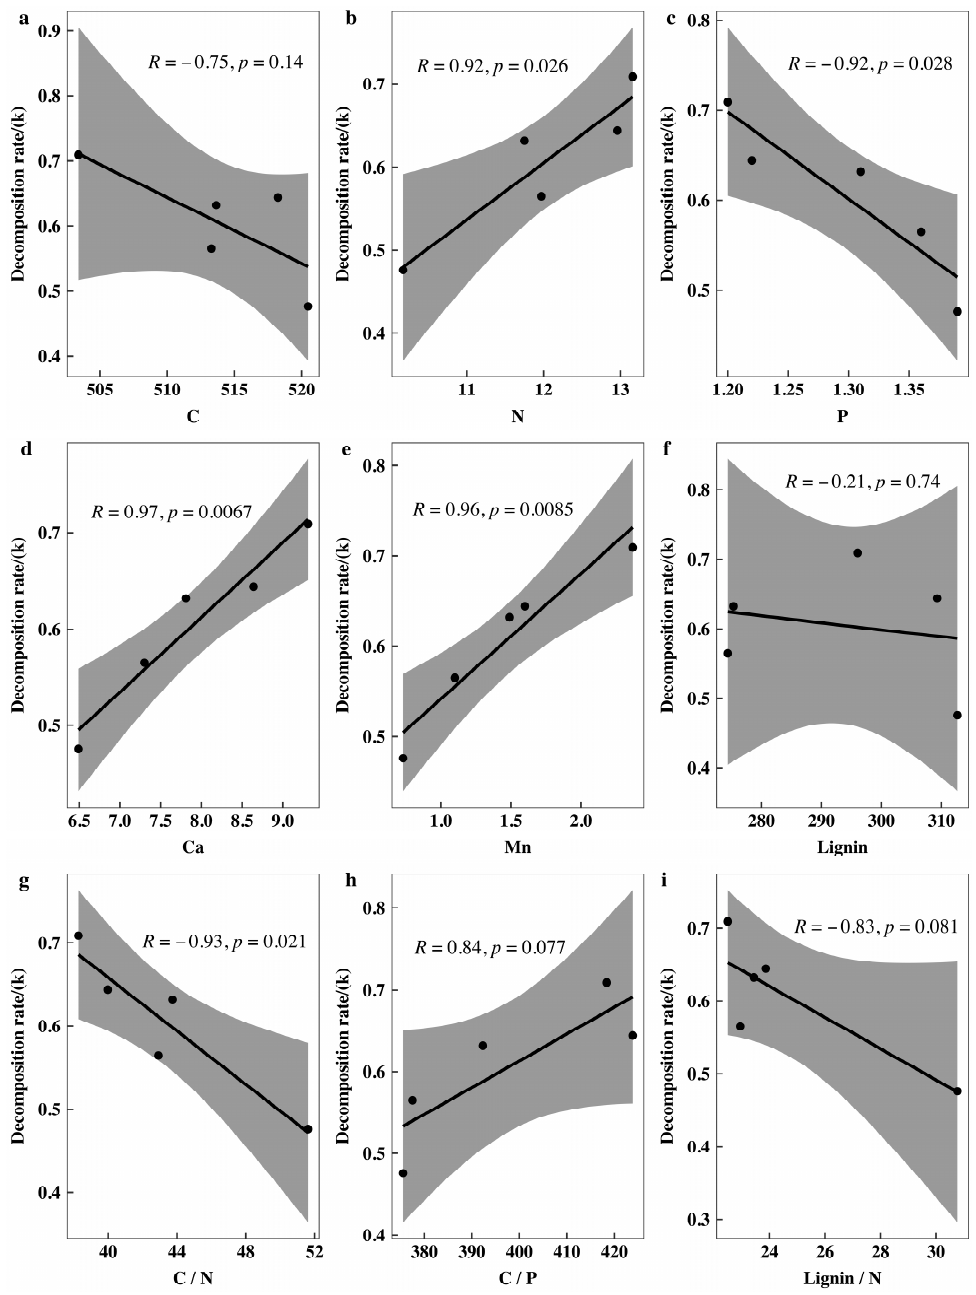
Figure 9. Relationships between the initial concentrations of some major nutrients, lignin, and eco- stoichiometric ratios in leaf litter (mg · g − 1 DM) taken from different altitude Qinghai spruce sites shown with the initial decomposition rate ( k ). ( a ) The relationship between C concentration and the initial decomposition rate of litter. ( b ) The relationship between N concentration and the initial decomposition rate of litter. ( c ) The relationship between P concentration and the initial decomposi- tion rate of litter. ( d ) The relationship between Ca concentration and the initial decomposition rate of litter. ( e ) The relationship between Mn concentration and the initial decomposition rate of litter. ( f ) The relationship between lignin concentration and the initial decomposition rate of litter. ( g ) The relationship between eco-stoichiometric ratio C/N and the initial decomposition rate of litter. ( h ) The relationship between eco-stoichiometric ratio C/P and the initial decomposition rate of litter. ( i ) The relationship between eco-stoichiometric ratio lignin/N and the initial decomposition rate of